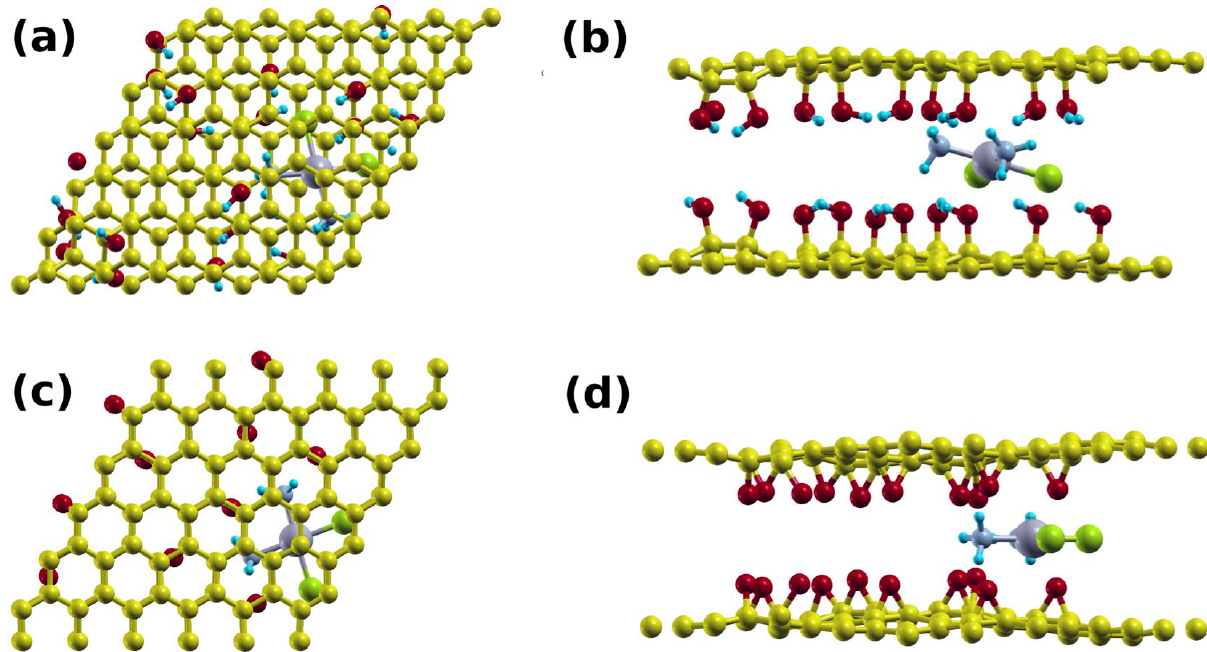
Figure 6. Supercell of the ( a ) top view; and ( b ) side view of the cisplatin double layer GO1 system; and ( c ) top view and ( d ) side view of the cisplatin double layer GO2 system. and ( c ) top view and ( d ) side view of the cisplatin double layer GO2